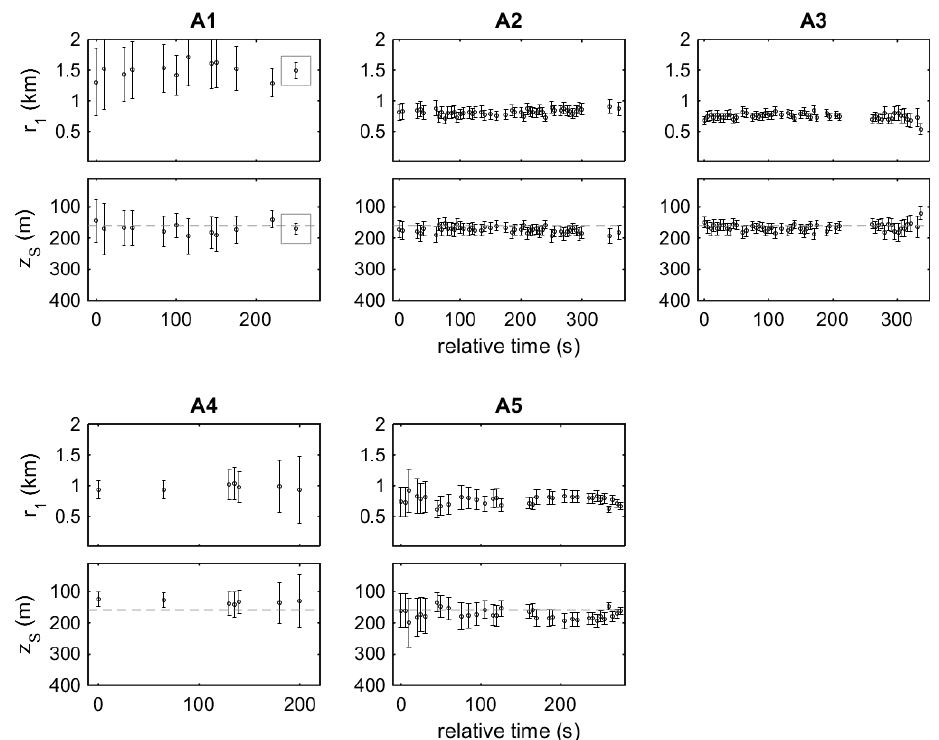
Figure 8. Localization results for source range (from front hydrophone) and source depth during stations A1–A5 of the shallow-water experiment. The error bars about the estimated means ( ◦ ) indicate the posterior RMS errors. The dashed lines represent the anticipated pinger depth (160 m). The framed results at station A1 correspond to the averages of individual estimates.